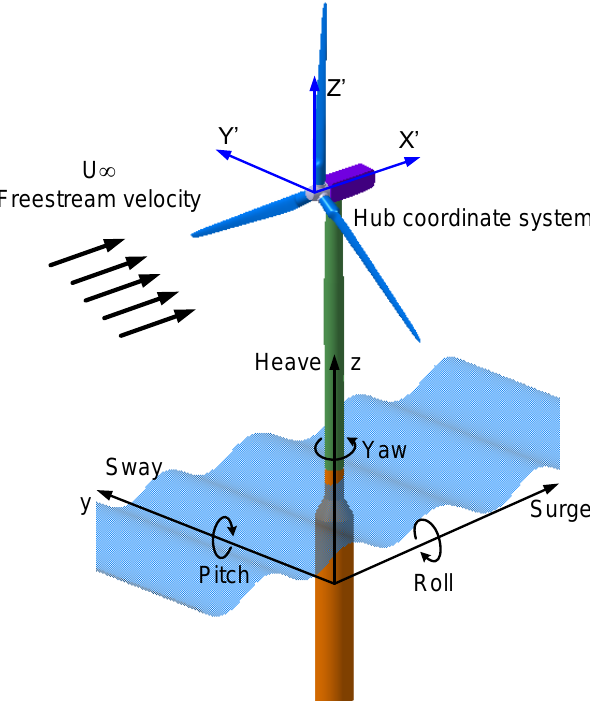
Figure 1. Degrees of freedom for an offshore floating wind turbine